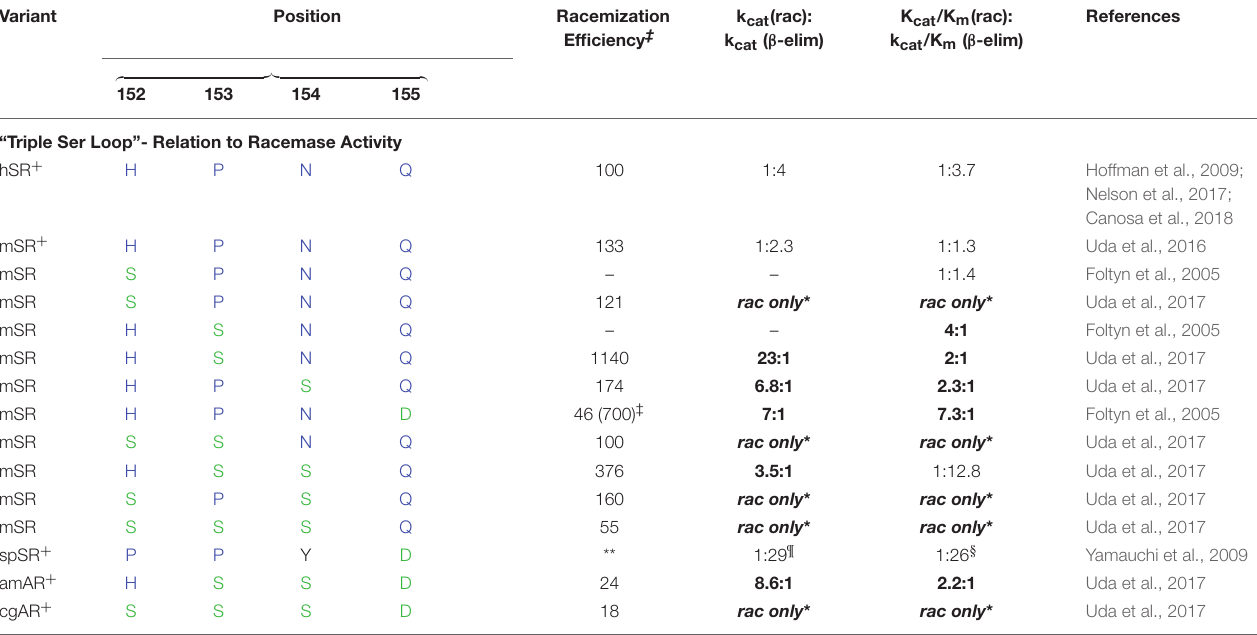
TABLE 2 | Kinetic indication that mutations of SR residues in the “triple serine loop” to the corresponding aspartate racemase (AR) residues tends to bias enzyme activity toward racemization over β -elimination.